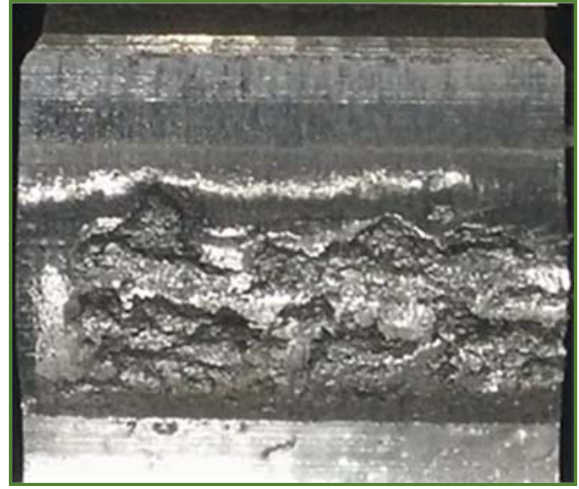
Figure 6. Example of pitting.